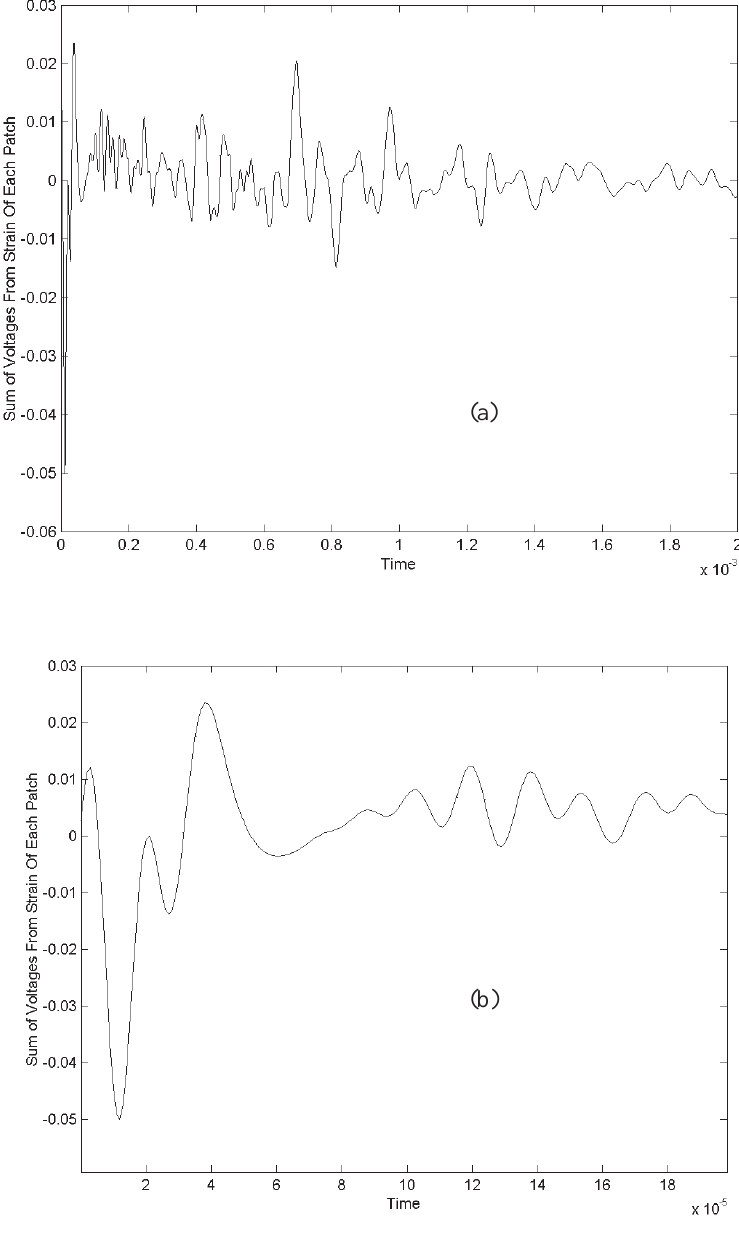
Fig. 7. Voltage time history due to center actuation by a PZT patch; (a) continuous sensor voltage for 2 ms, (b) continuous sensor voltage for 0.2 ms. due to step excitation. For an impulse moment actuation the plate displacement is expressed in terms of a Fourier series (Navier’s solution) and by summation of modes including damping as shown